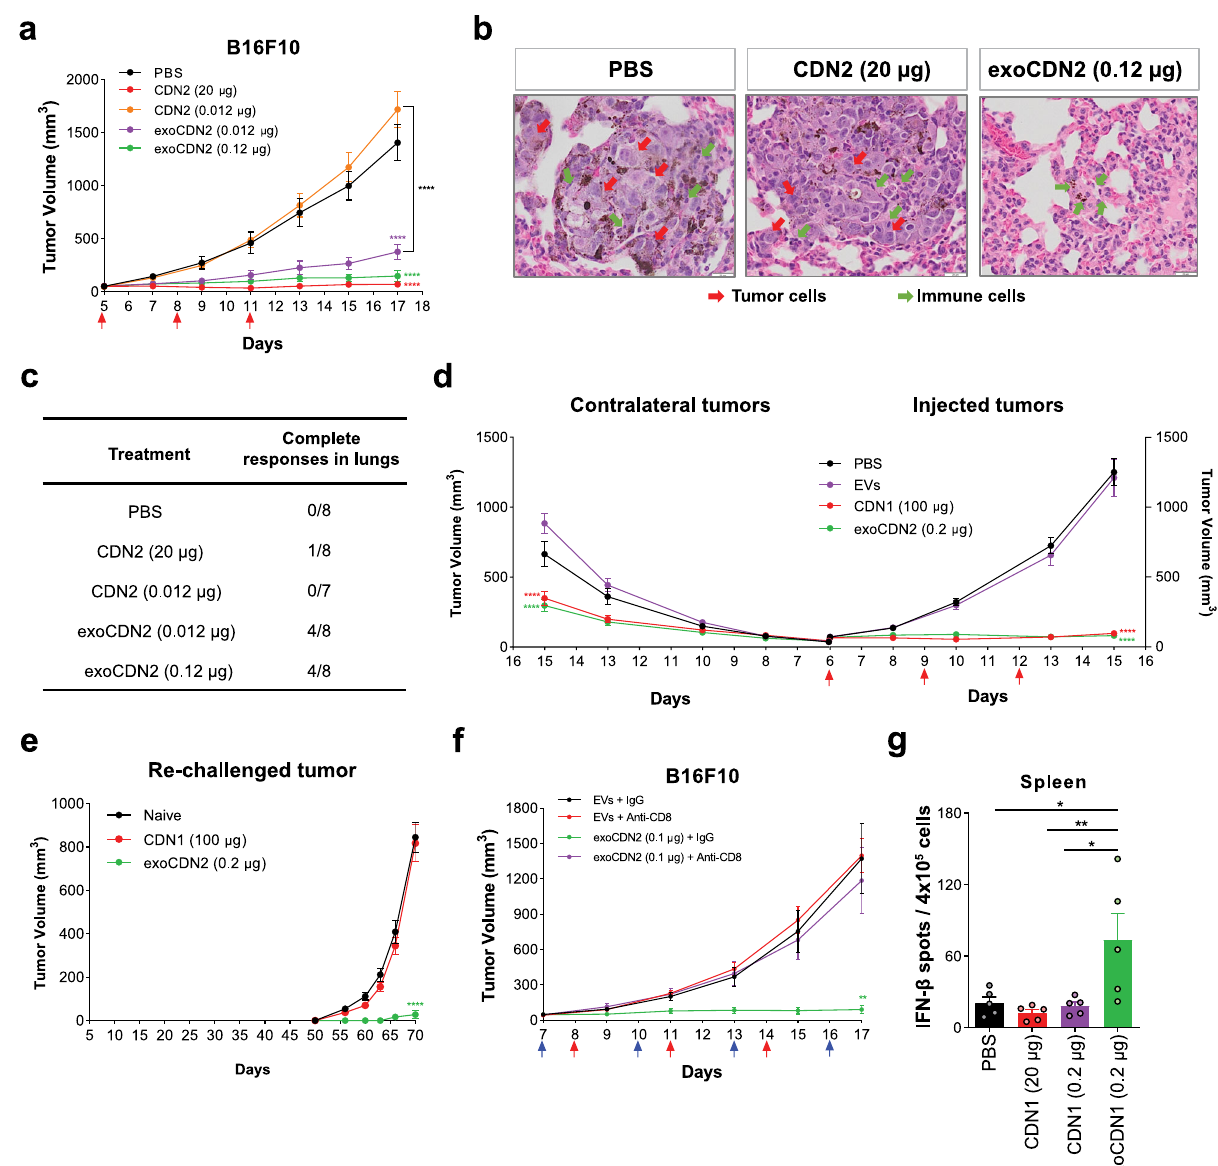
Fig. 2 exoSTING elicits strong anti-tumor responses with systemic tumor-speci fi c immune activation in a B16F10 tumor model. a – c B16F10 tumor cells (1 × 10 6 cells) were implanted subcutaneously in right fl ank of C57BL/6 mice. At Day 4, B16F10 tumor cells (1 × 10 5 cells) were injected intravenously to induce lung metastasis. PBS, free CDN2 (20 or 0.012 µ g) and exoCDN2 (0.012 or 0.12 µ g) were injected into subcutaneous tumors ( n = 8 animals per group). Tumor growth curves of subcutaneous tumors ( a ), representative H&E stained images from PBS, CDN2 (20 µ g), and exoCDN2 (0.12 µ g) ( b ),